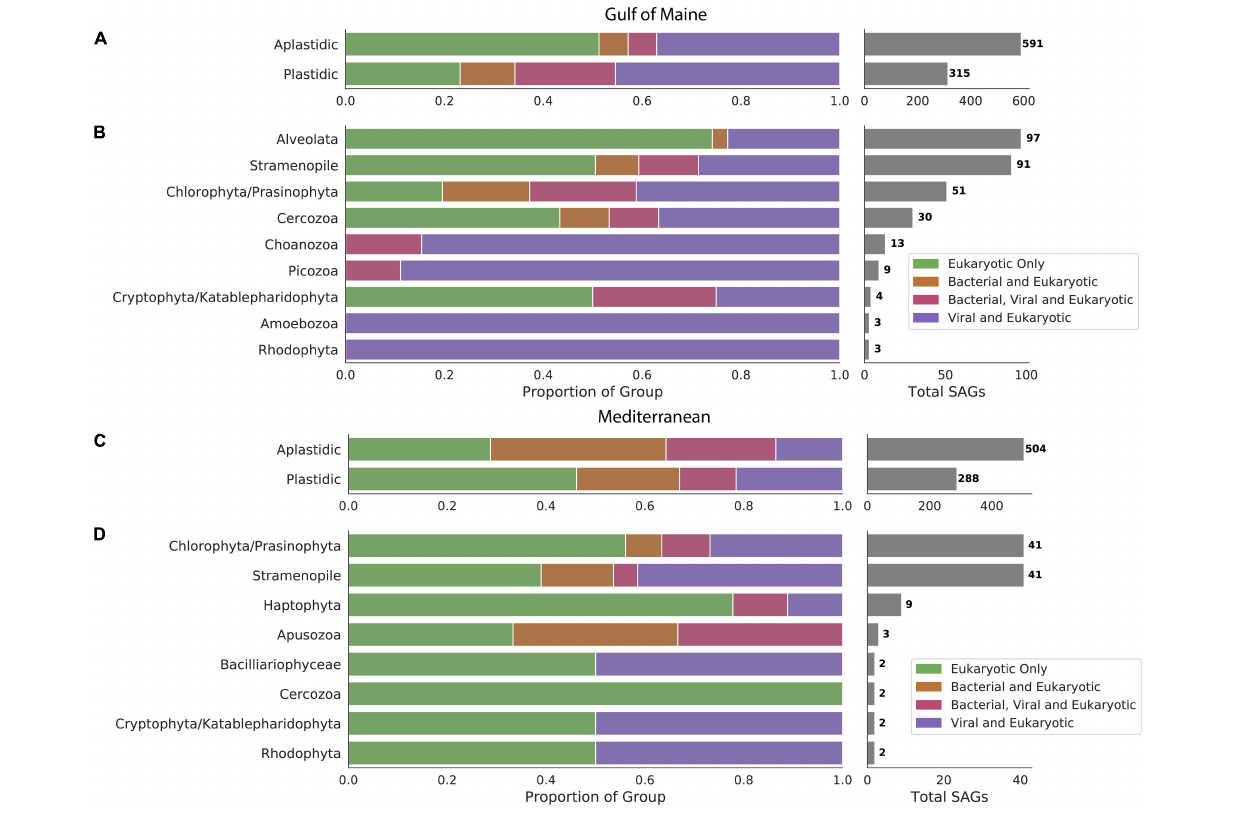
FIGURE 1 | Occurrence of bacterial and viral DNA in protistan SAGs sampled from the Gulf of Maine (A) and the Mediterranean Sea (C) . Distribution of viral and bacterial DNA within cells with identifiable 18S rRNA genes sampled from the Gulf of Maine (B) and the Mediterranean Sea (D)